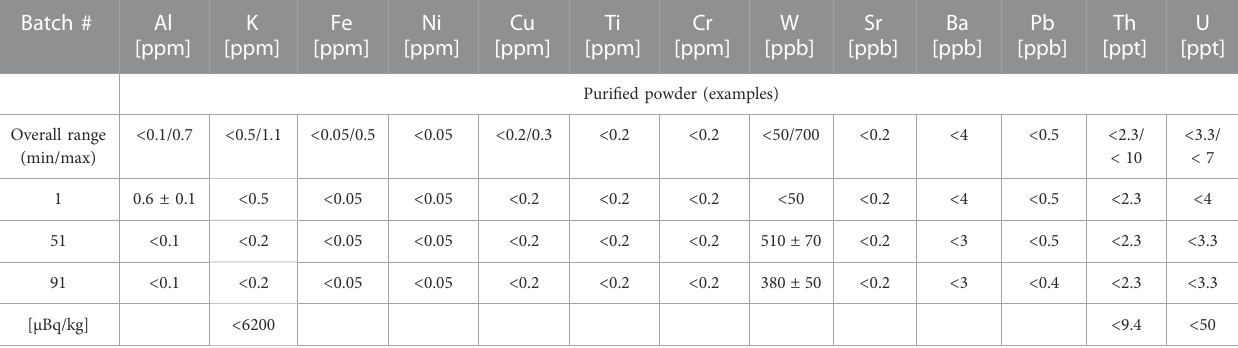
TABLE2Purityof 100 MoO 3 powdertreatedatCUP. Inthelast row,thevaluesareexpressed in μ Bq/kg(1 ppm=31mBq/kgfor 40 K,1 ppt=4.1 μ Bq/kgfor 232 Th,and 12.4 μ Bq/kg for 238 U). Values and upper limits are given at 95% C.L. Batch #